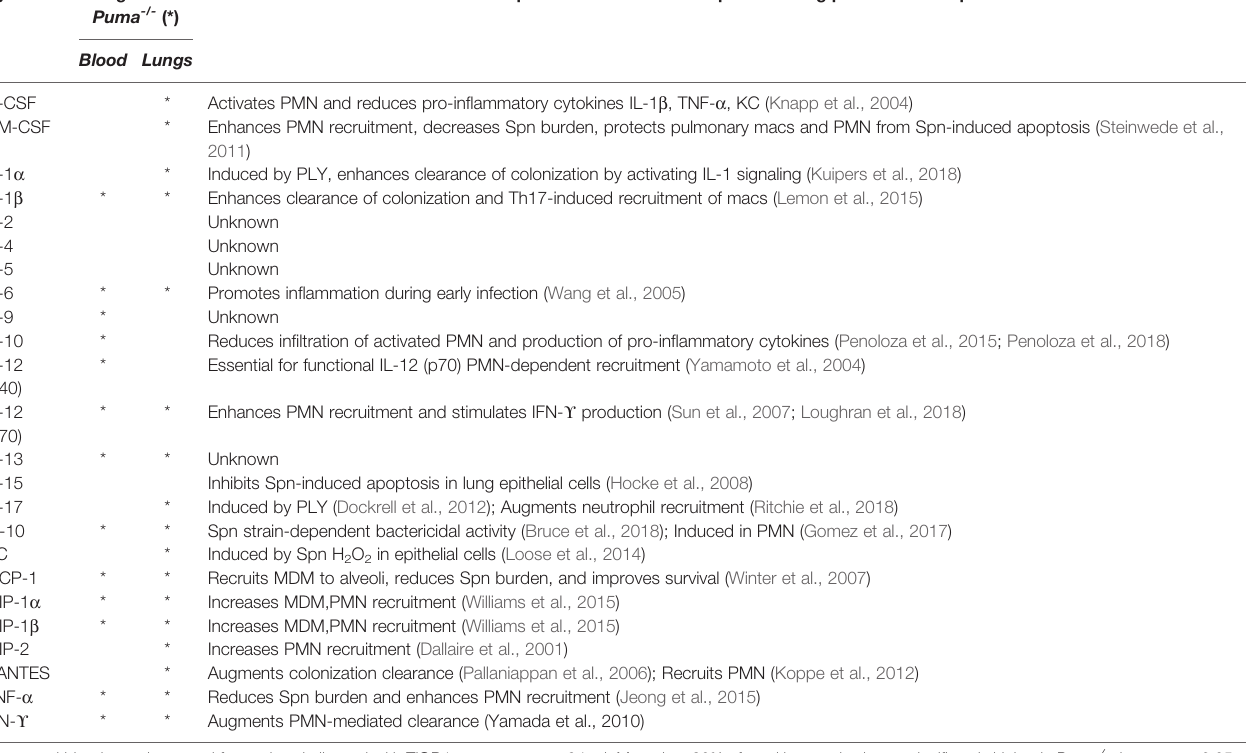
TABLE 2 | Pro-in fl ammatory cytokine pro fi le of Puma -/- mice during early innate immune response. Known or suspected role in innate response during pneumococcal Cytokine Higher in Puma -/- (*)